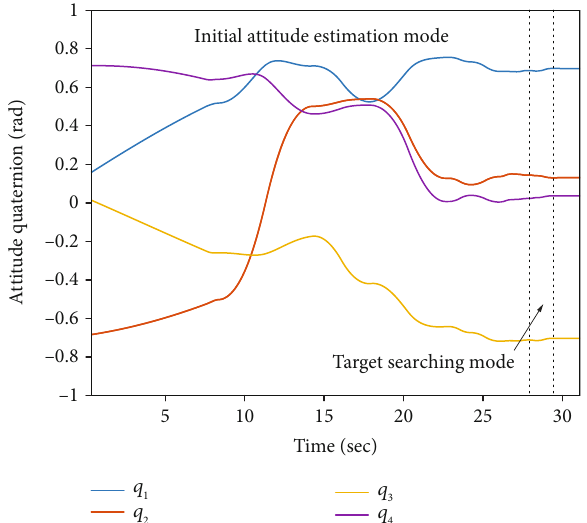
Figure 7: Time history of attitude quaternion during initial attitude estimation mode and target searching mode.